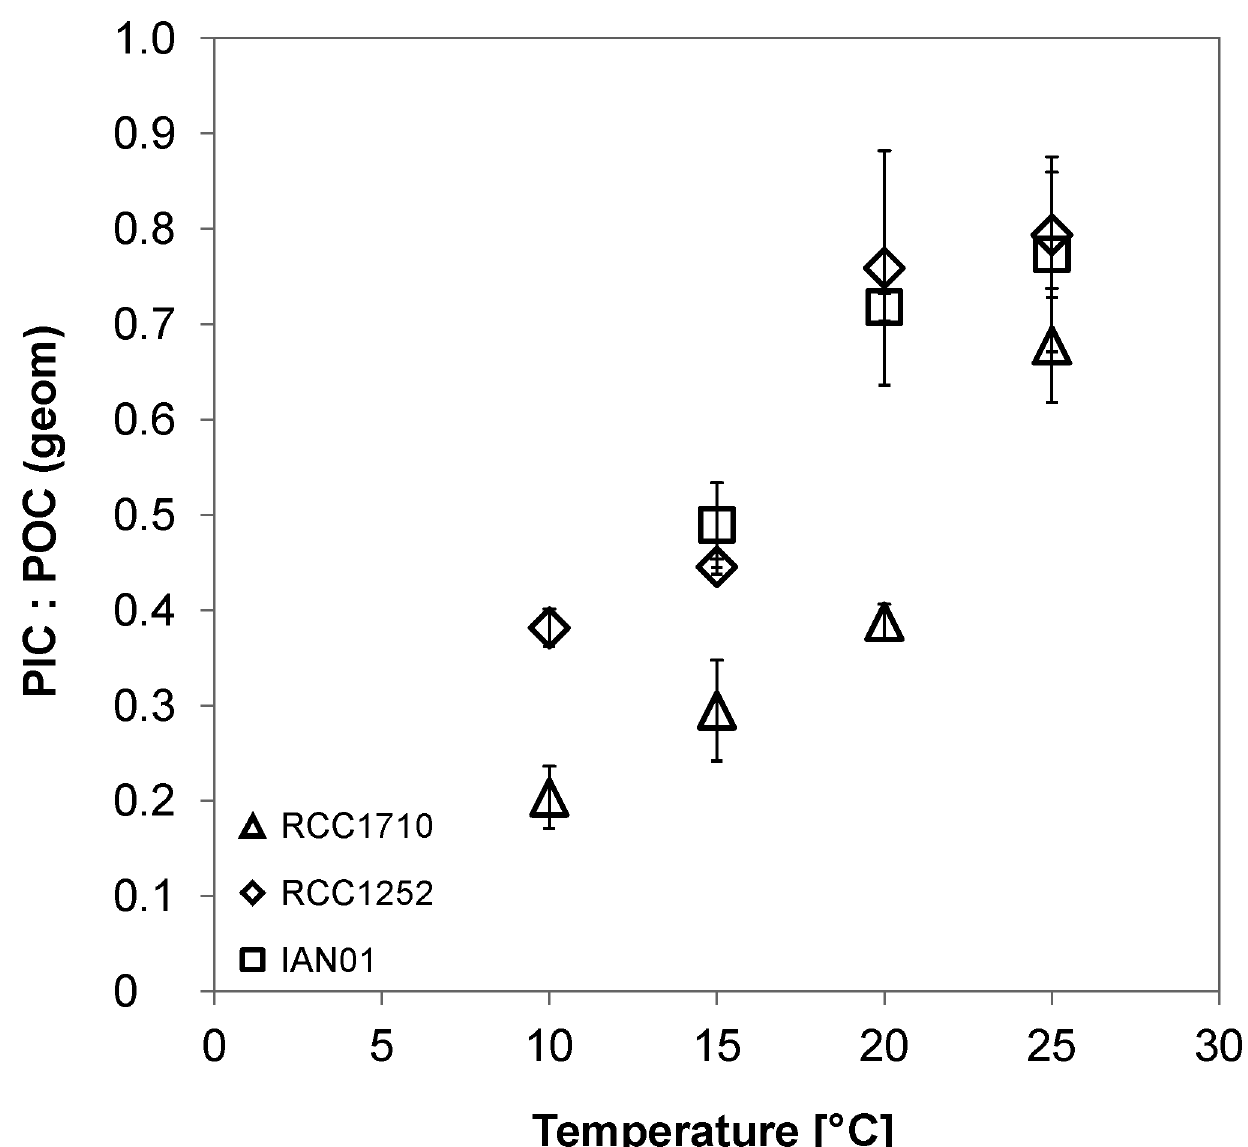
Fig 4. Geometrically derived ratio between the particulate inorganic carbon and the particulate organic carbon (PIC: POC) in the individual cells of three different strains of E . huxleyi grown at different temperatures. The strains are RCC1710 (triangle symbols), RCC1252 (diamond symbols), and IAN01 (square symbols). Standard deviations of the triplicate experiment results are shown.